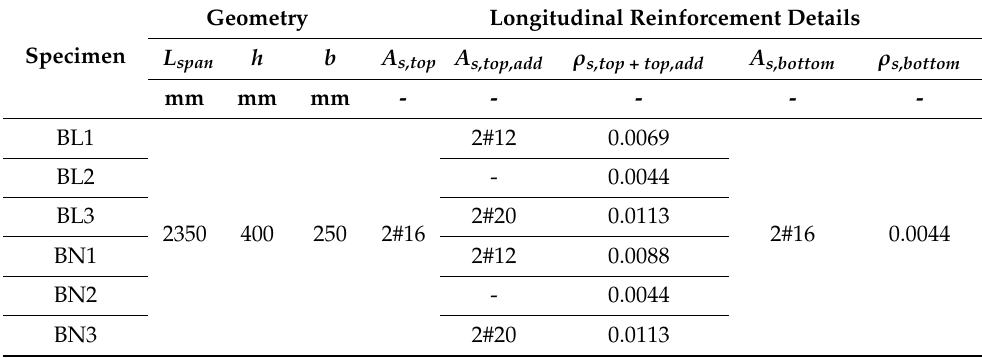
Table 1. Details of beam specimens.